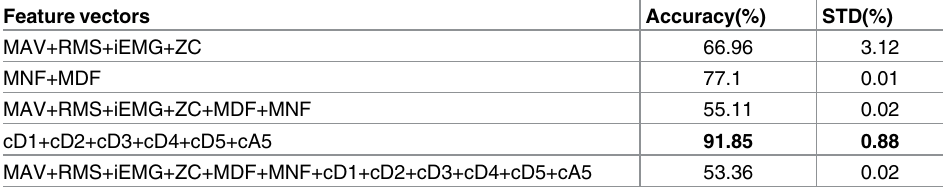
STD represents the percentage of the standard deviation over the corresponding